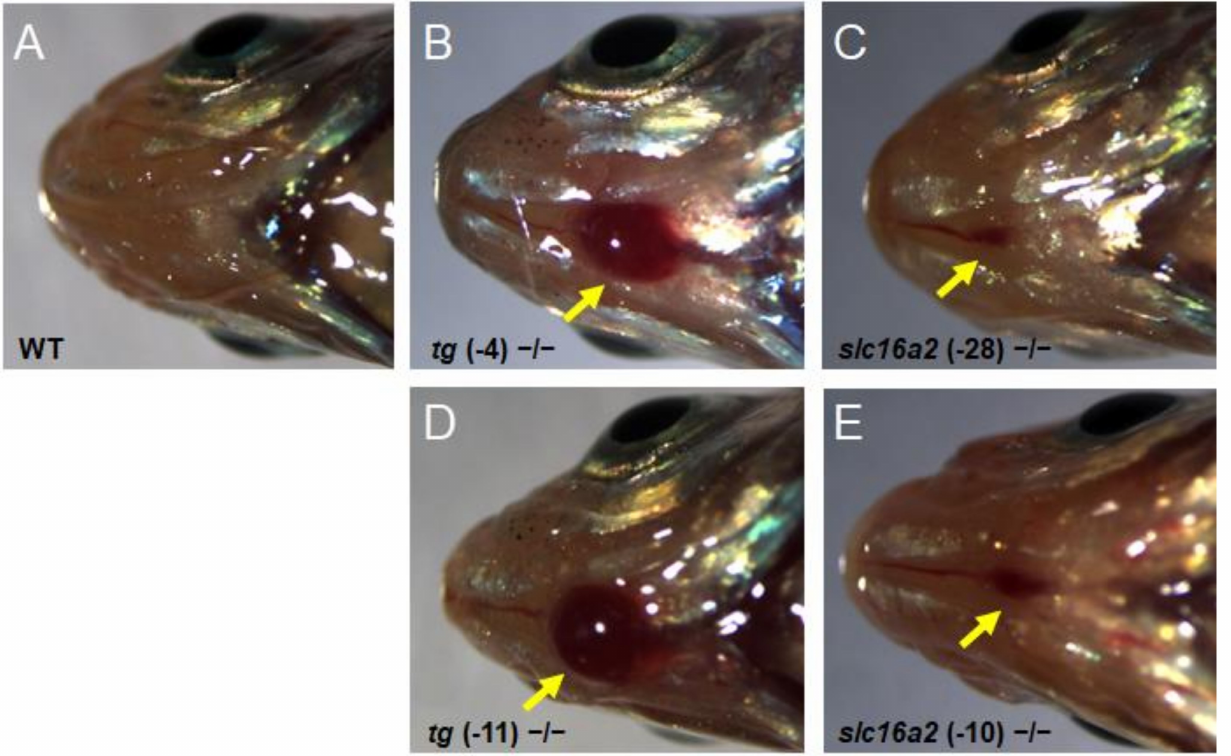
Figure 9. Goiter seen in tg mutant and slc16a2 mutant zebrafish. ( A – E ) Representative macroscopical pictures of the head region of wild-type zebrafish ( A ), tg (-4) zebrafish ( B ), tg (-11) mutant zebrafish ( C ), slc16a2 (-10) mutant zebrafish ( D ), and slc16a2 (-28) mutant zebrafish ( E ) at 3 mpf. The red mass of the thyroid is indicated by the yellow